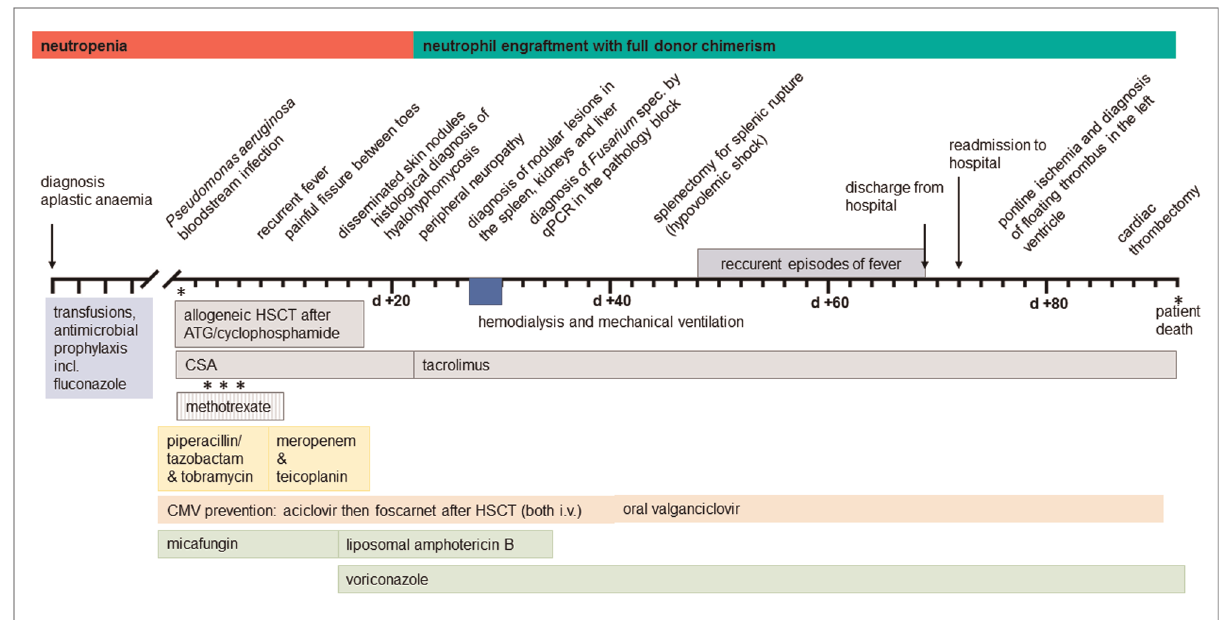
FIGURE 4 Synopsis of the clinical course and treatment. HSCT, hematopoietic stem cell transplantation; ATG, antithymocyte globulin; CSA, ciclosporin A; CMV,